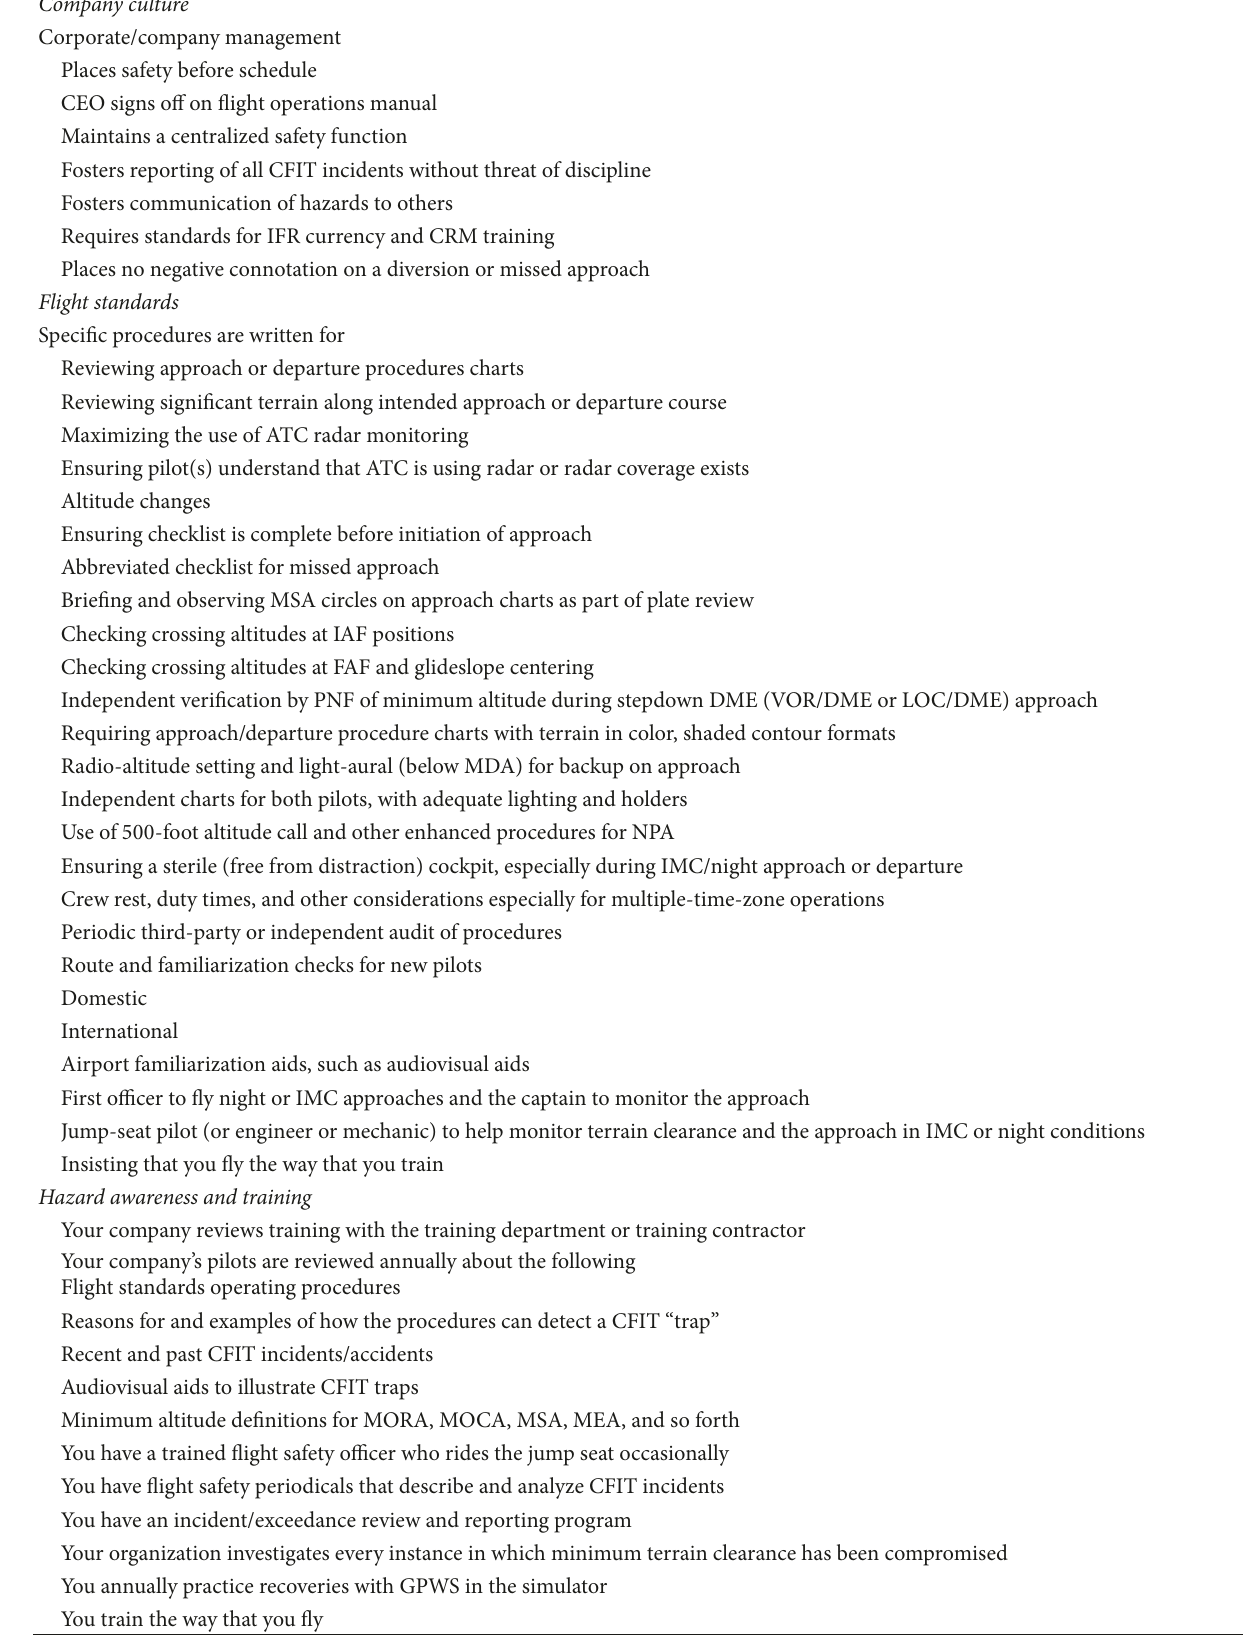
Table 7: Risk reduction/mitigation assessment